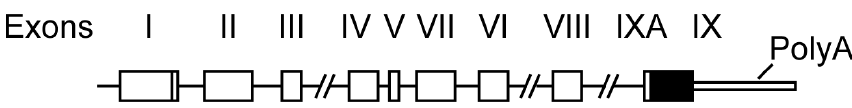
Figure 1. Brain-derived neurotrophic factor ( Bdnf ) gene structure. The mouse Bdnf gene is depicted here. White boxes indicate untranslated exons and the black box indicates a coding exon (IX).